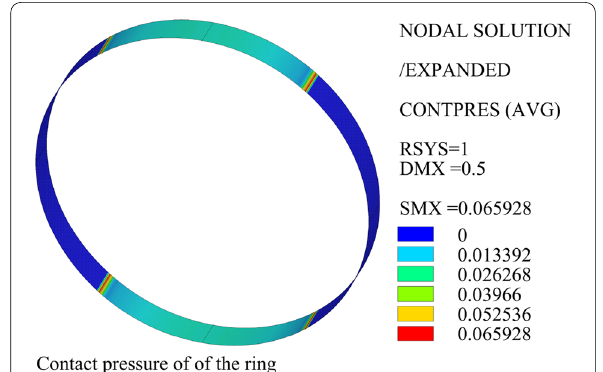
Figure 4 Nephogram of the contact pressure between the ring and elliptical